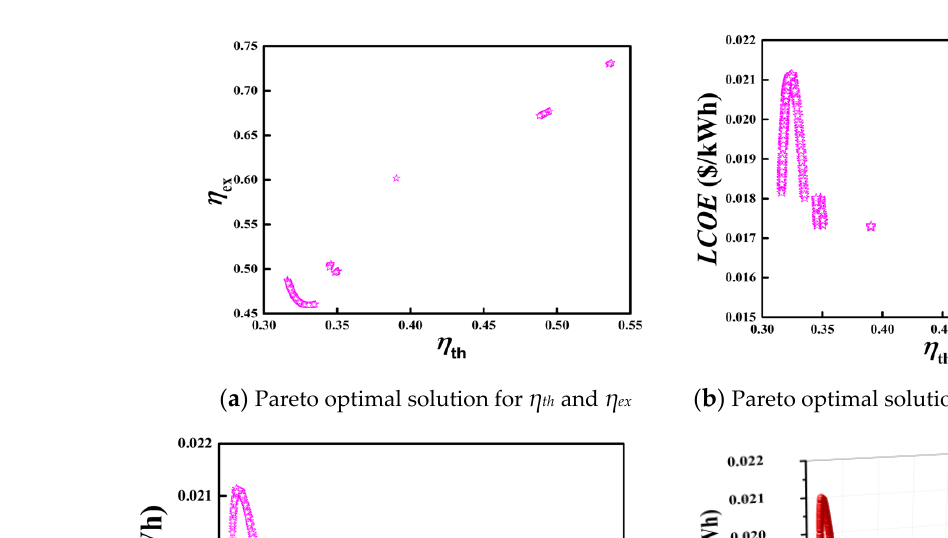
Figure 14. Three objectives Pareto optimal solution for η th , η ex , and LCOE.